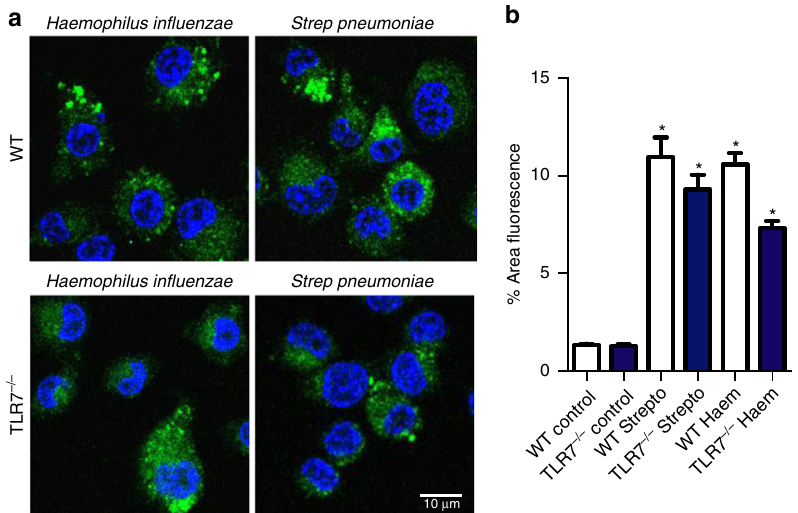
Fig. 4 Bacteria-induced ROS production is distinct from virus-dependent ROS mechanisms. a Phagosomal superoxide production to Haemophilus in fl uenzae and Streptococcus pneumoniae as assessed by OxyBURST (100 μ M) fl uorescence microscopy in WT and TLR7 − / − immortalized bone marrow derived macrophages. Images are representative of > 150 cells analyzed over each experiment. Original magni fi cation ×100. b Is the quanti fi cation of the results ( n = 5). All data are represented as mean ± S.E.M. One-way ANOVA followed by Dunnett ’ s post hoc test for multiple comparisons. * P < 0.05 compared to WT control. Scale bar: 10 µ